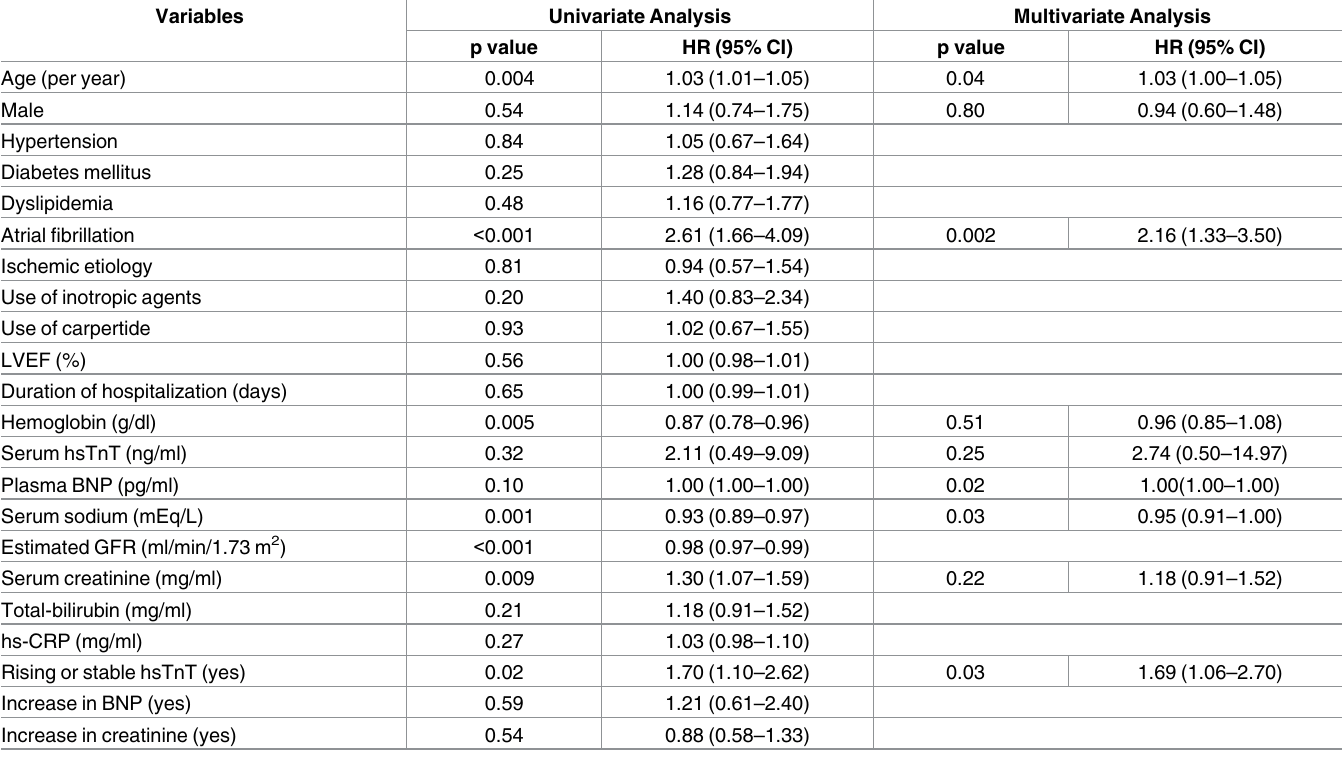
Table 4. Results of univariate and multivariate Cox proportional hazards regression analyses for heart-failure related